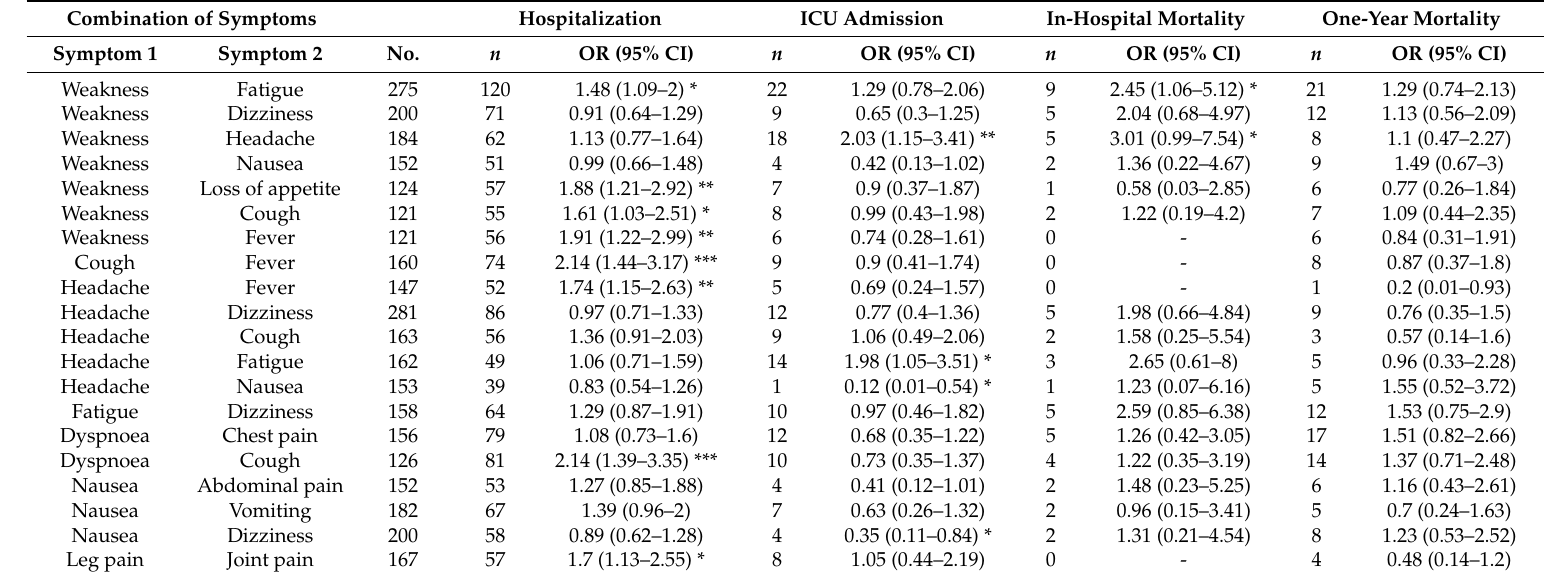
Table 2. Age-, sex-, and ESI-triage-level-adjusted multivariable logistic regression